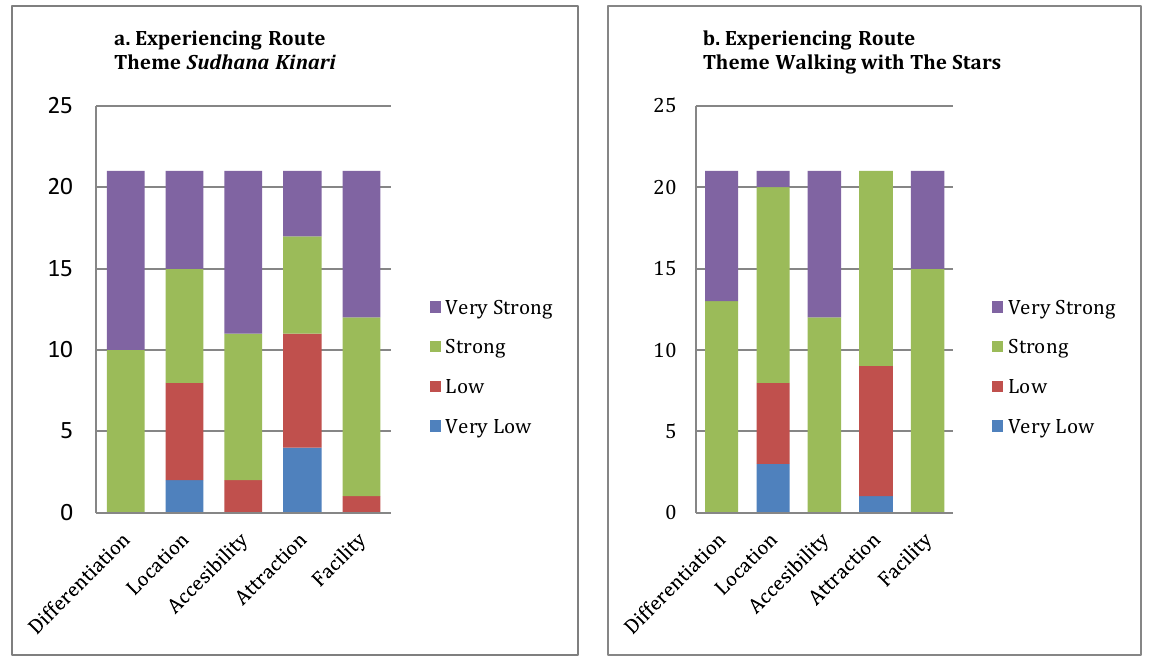
Fig. 7 Experiencing Route Theme 1; a Sudhana Kinari , b Walking with the